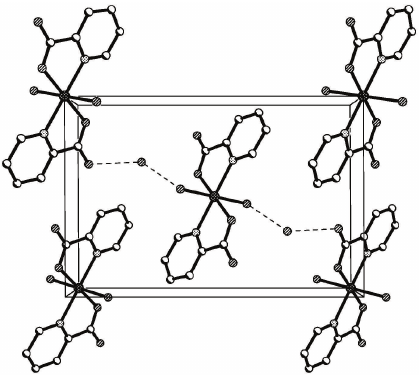
Figure 3: Crystal packing diagram of the title